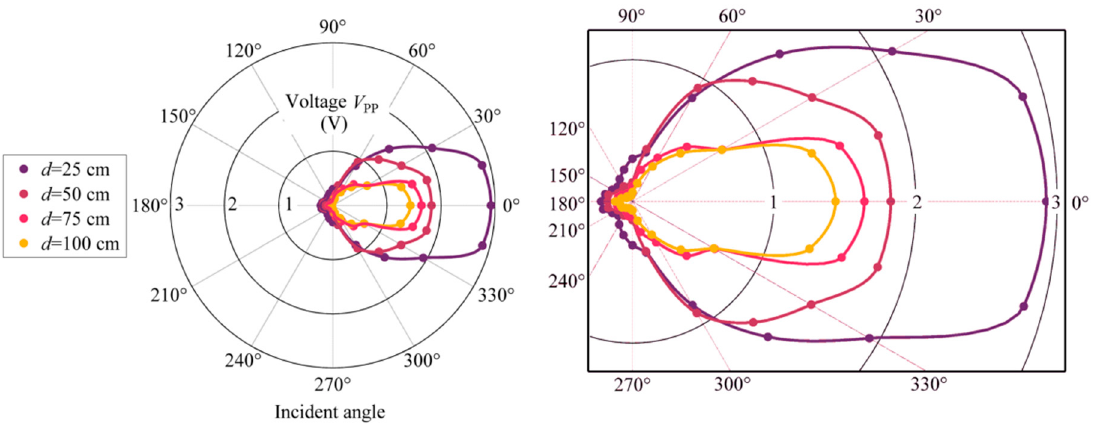
Figure 6. Ultrasonic signals detected at different incident angles and distances.